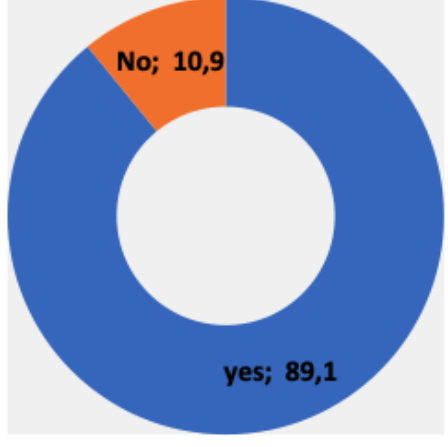
Figure 2: Managers Perception on Clarity of Mission; Source: Research Data 2018